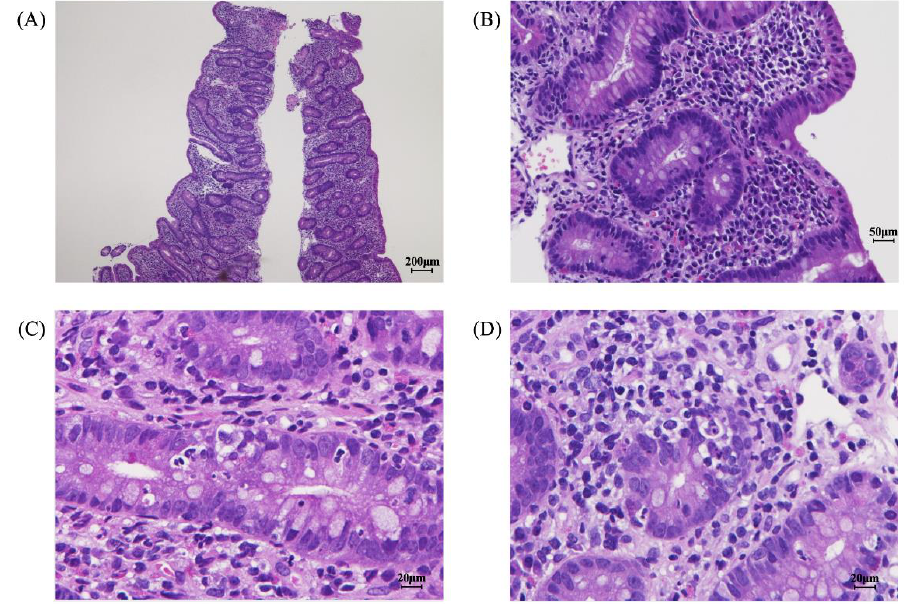
Figure 1. Pathologic findings in the gastrointestinal mucosa at diagnosis. Loss of mucosal villous structure, crypt hyperplasia ( A , B ), crypt apoptosis ( C ), and lymphocyte and eosinophil infiltration into the lamina propria were observed ( D ).